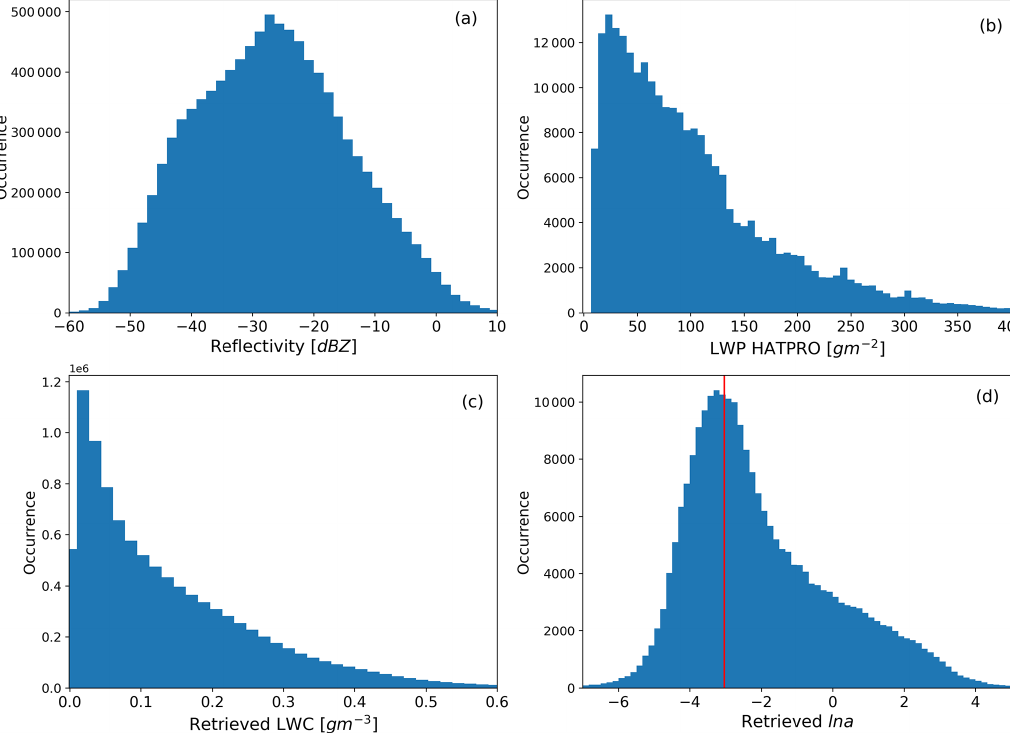
Figure 11. Histogram of (a) radar reflectivity ( Z ), (b) LWP from MWR, (c) retrieved LWC, and (d) retrieved ln a for 39 cloudy days. The red line in the ln a histogram indicates the a priori estimate of ln a from Table 1.